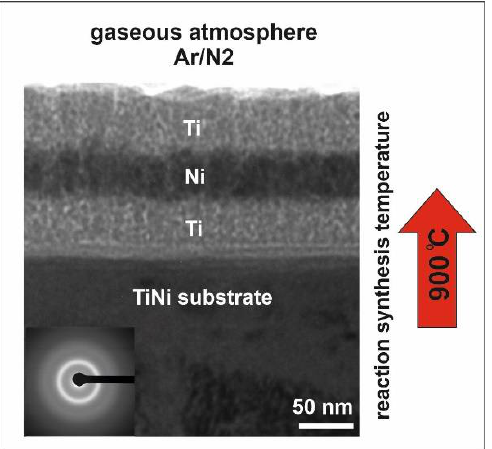
Figure 1. Scheme of deposition of the amorphous Ti/Ni/Ti nanolaminate and synthesis of coating.